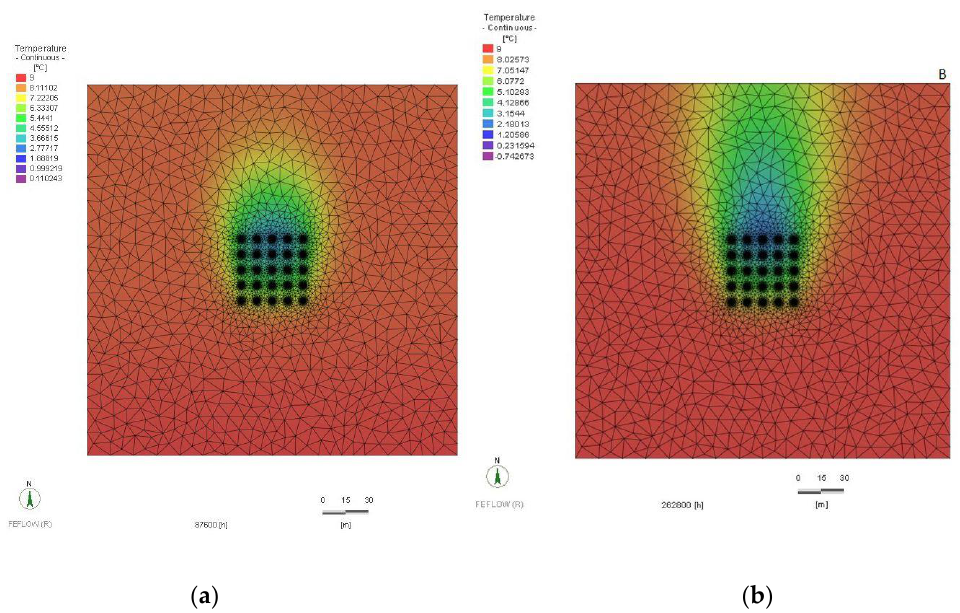
Figure 5. Results of the simulation of ground temperature after 10 years ( a ) and 30 years ( b ) of heat pump operation within the 1st scenario (homogeneous model). Two-dimensional view of the surface at a depth of 50 m.